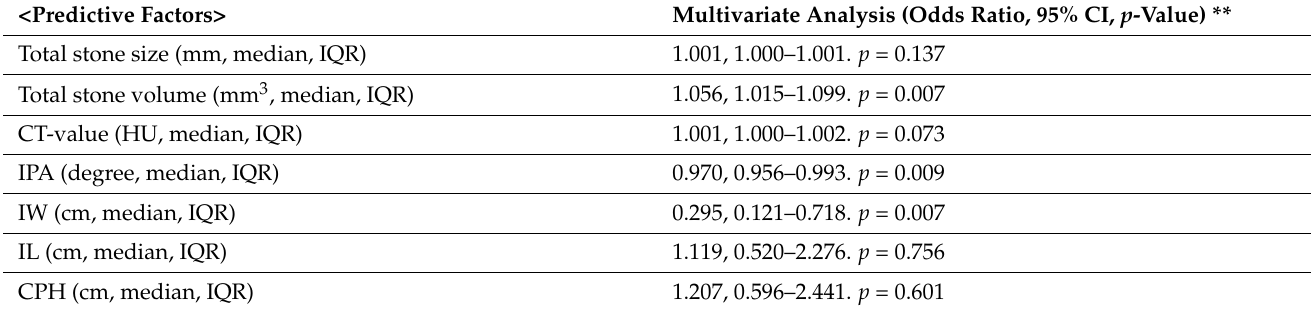
Table 3. Predictive risk factors of stone-free status after retrograde intrarenal surgery for lower pole calices.